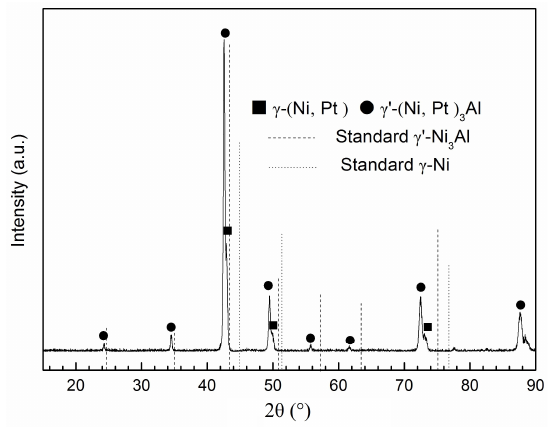
Figure 2. XRD pattern of the electroplated Pt coating after heat treatment at 1080 °C for 2 h.